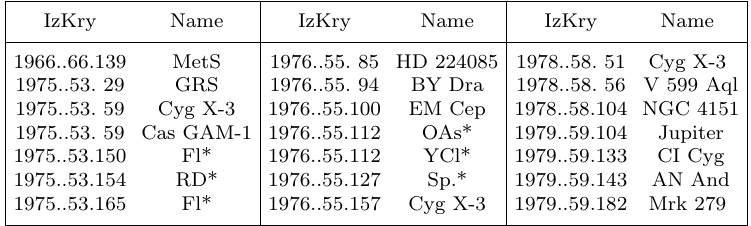
Table 1. Example of indexing the “Izvestiya of the CrAO” journal.